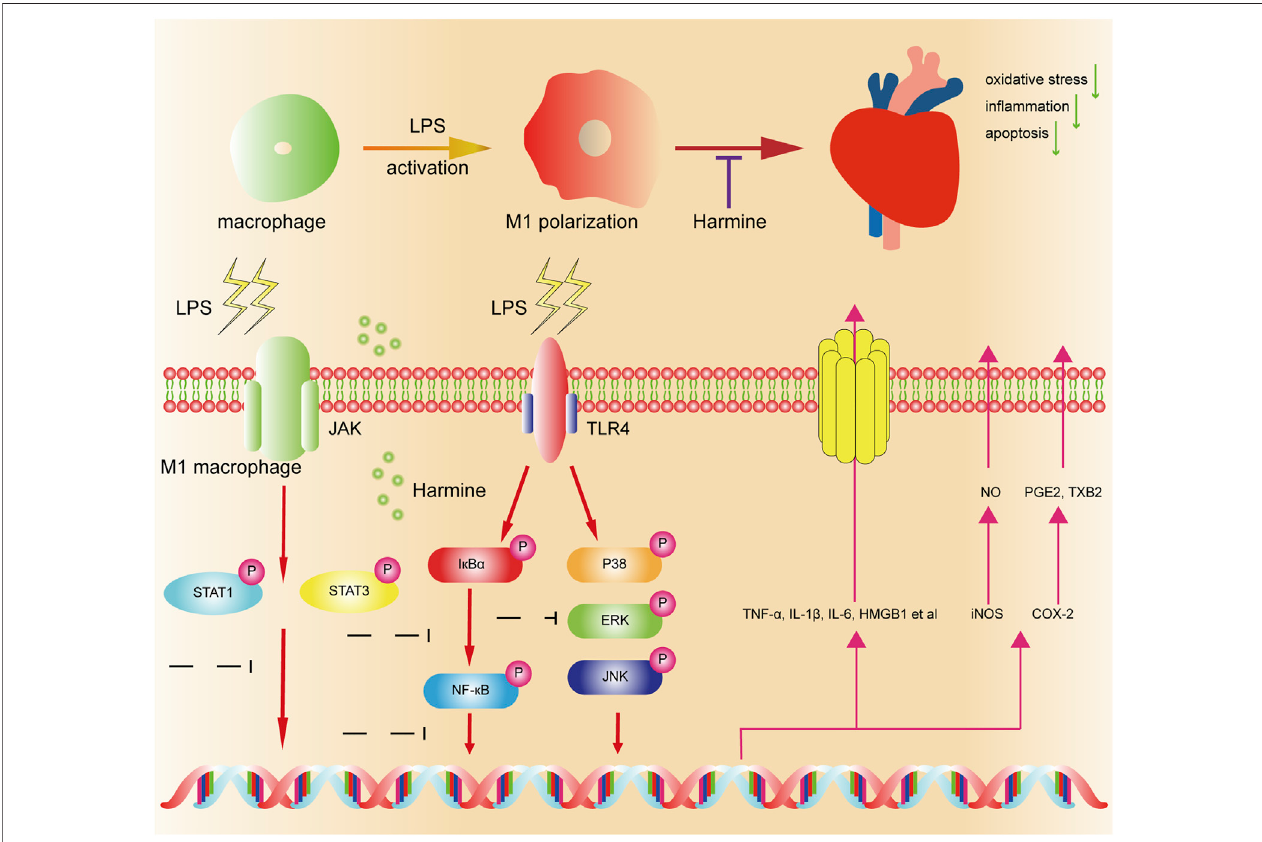
FIGURE7| Schematicdiagramoftheproposedmechanismunderlyingtheprotectiveeffectsofharmineonsepsis-inducedcardiacdysfunction.Macrophagesare activated by LPS and produce abundant in fl ammatory mediators (proin fl ammatory M1 phenotype). Harmine inhibits M1 macrophage polarization by suppressing the STAT1/3, MAPK, and NF- κ B pathways and subsequently reduces the release of in fl ammatory mediators. Ultimately, it alleviates cardiac oxidative stress, in fl ammation and apoptosis in vitro and in vivo .